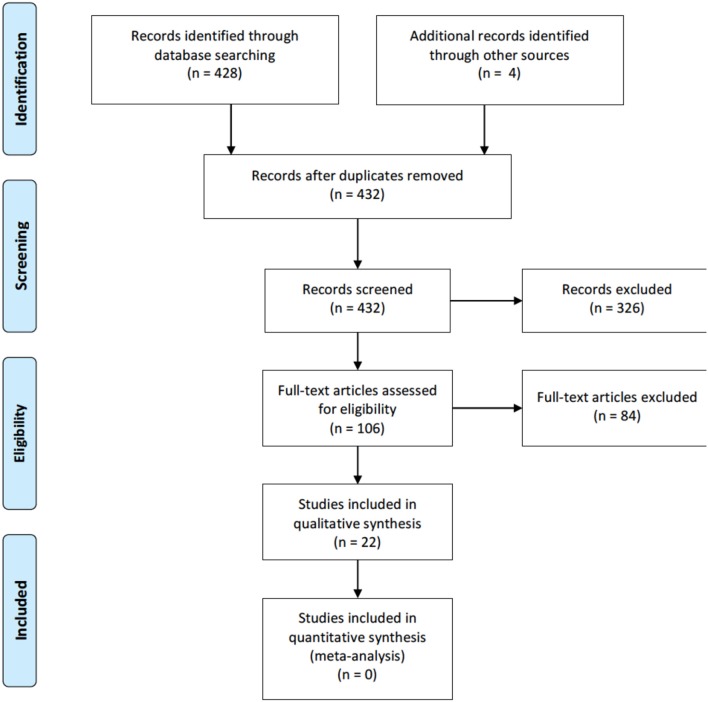
PRISMA flow diagram.